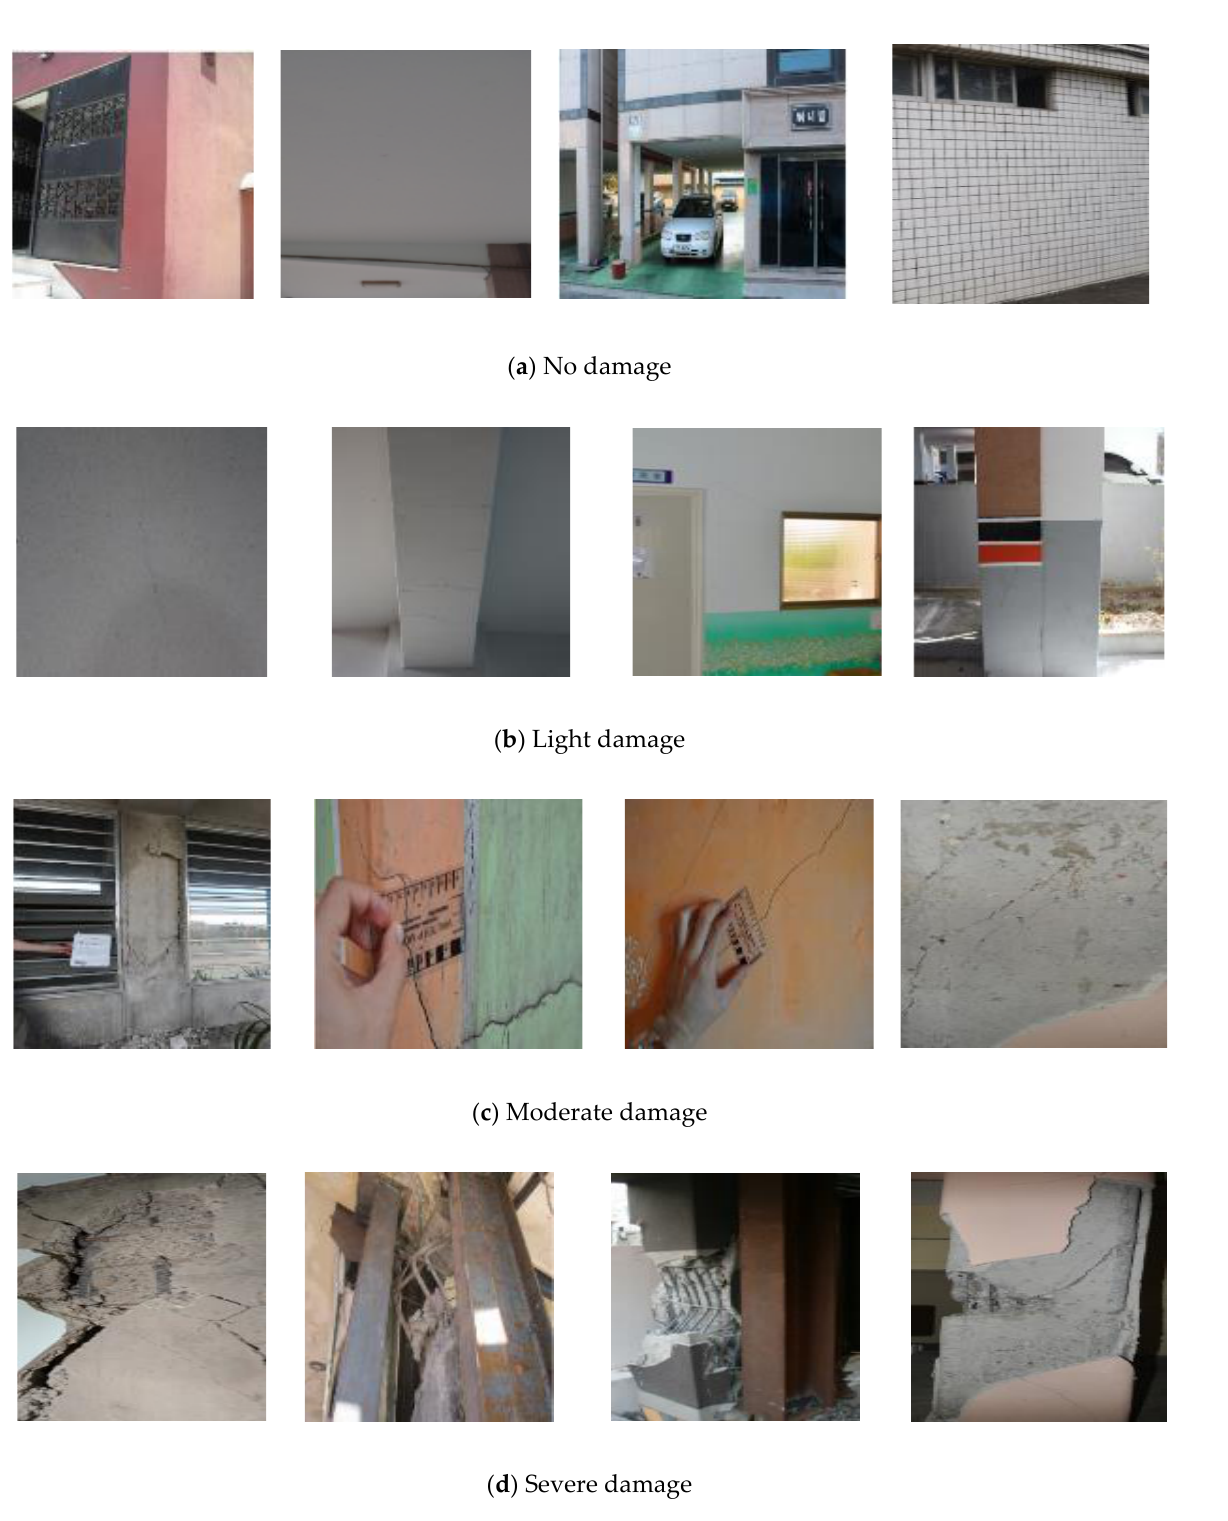
Figure 2. Samples used for training images for each damage class: ( a ) no, ( b ) light, ( c ) moderate, and ( d ) severe damage. ( d ) severe